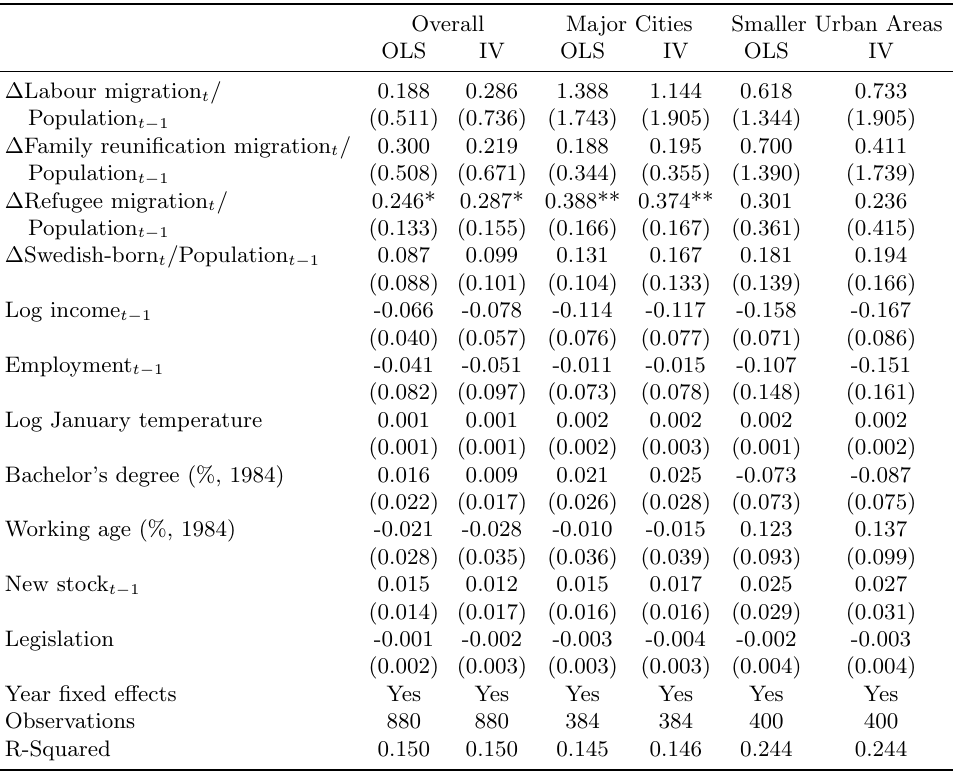
Table 4: Results by Reason for